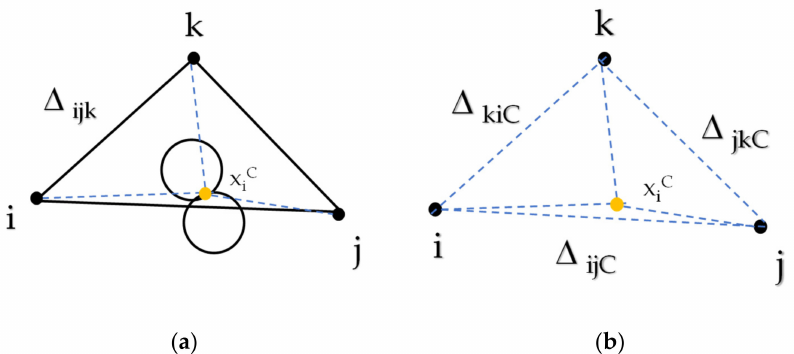
Figure 2. Contact model triangular shape functions at the contact point: ( a ) setting the associated inner triangles given the contact location; ( b ) inner triangles adopted for shape function